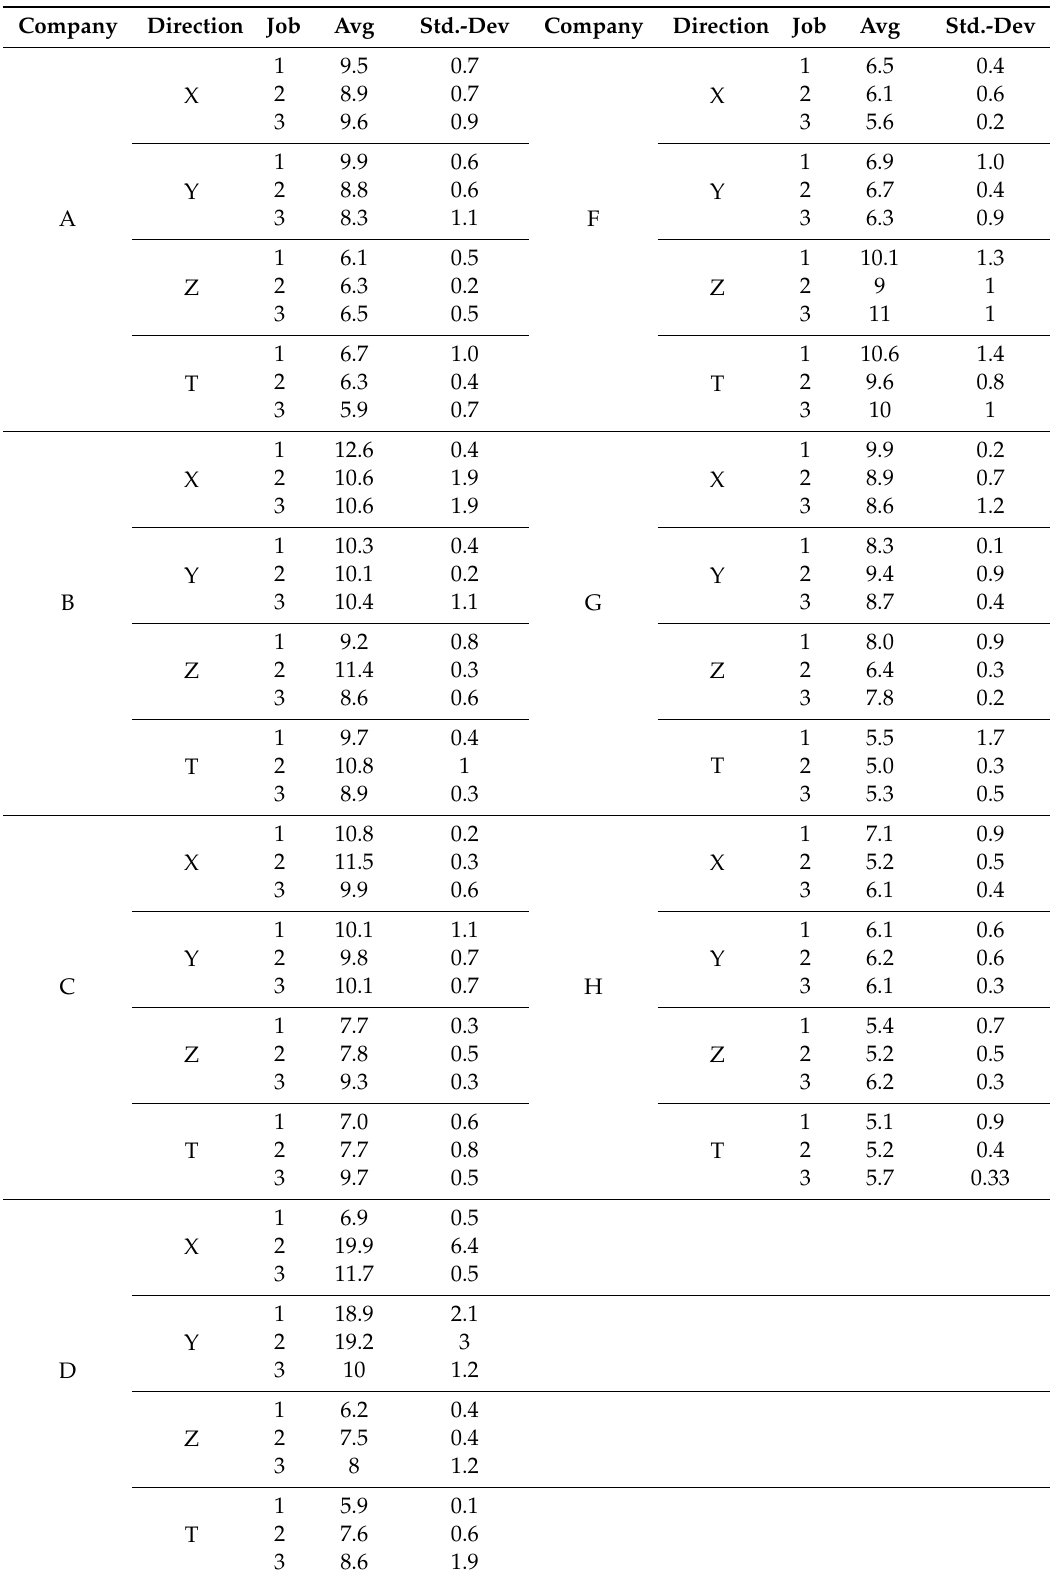
Table 9. Collection of results on surface roughness, Ra µ